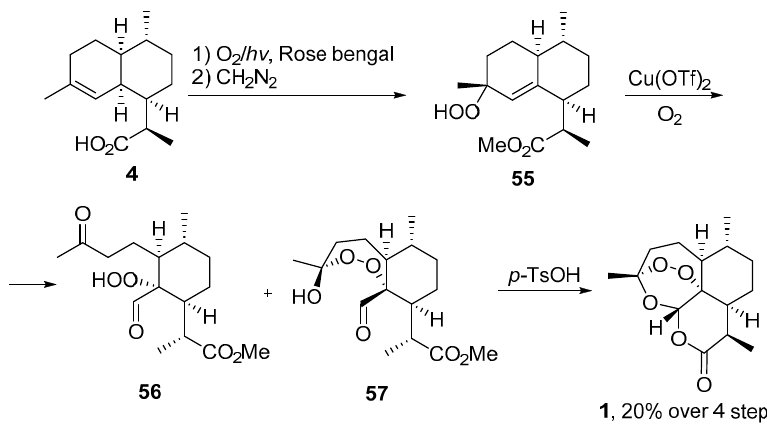
Scheme 12. The transformation of dihydroartemisinic acid ( 4 ) into artemisinin ( 1 ) via hydroperoxyester 55 . Later, many attempts have been made to in situ transformation of dihydroartemisinic acid ( 4 ) to artemisinin ( 1 ) (Table 1); however, the yield of artemisinin ( 1 ) did not exceed 30%. Table 1. In situ transformation of dihydroartemisinic acid ( 4 ) or its ester 19 into artemisinin ( 1 ).